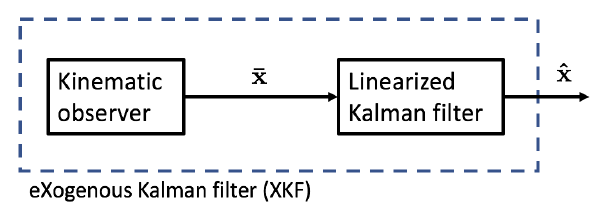
Figure 2: The XKF as a two-stage estimator. The kine- matic observer produces an estimate ¯ x used in a linearized KF, which returns the im- proved estimate ˆ x